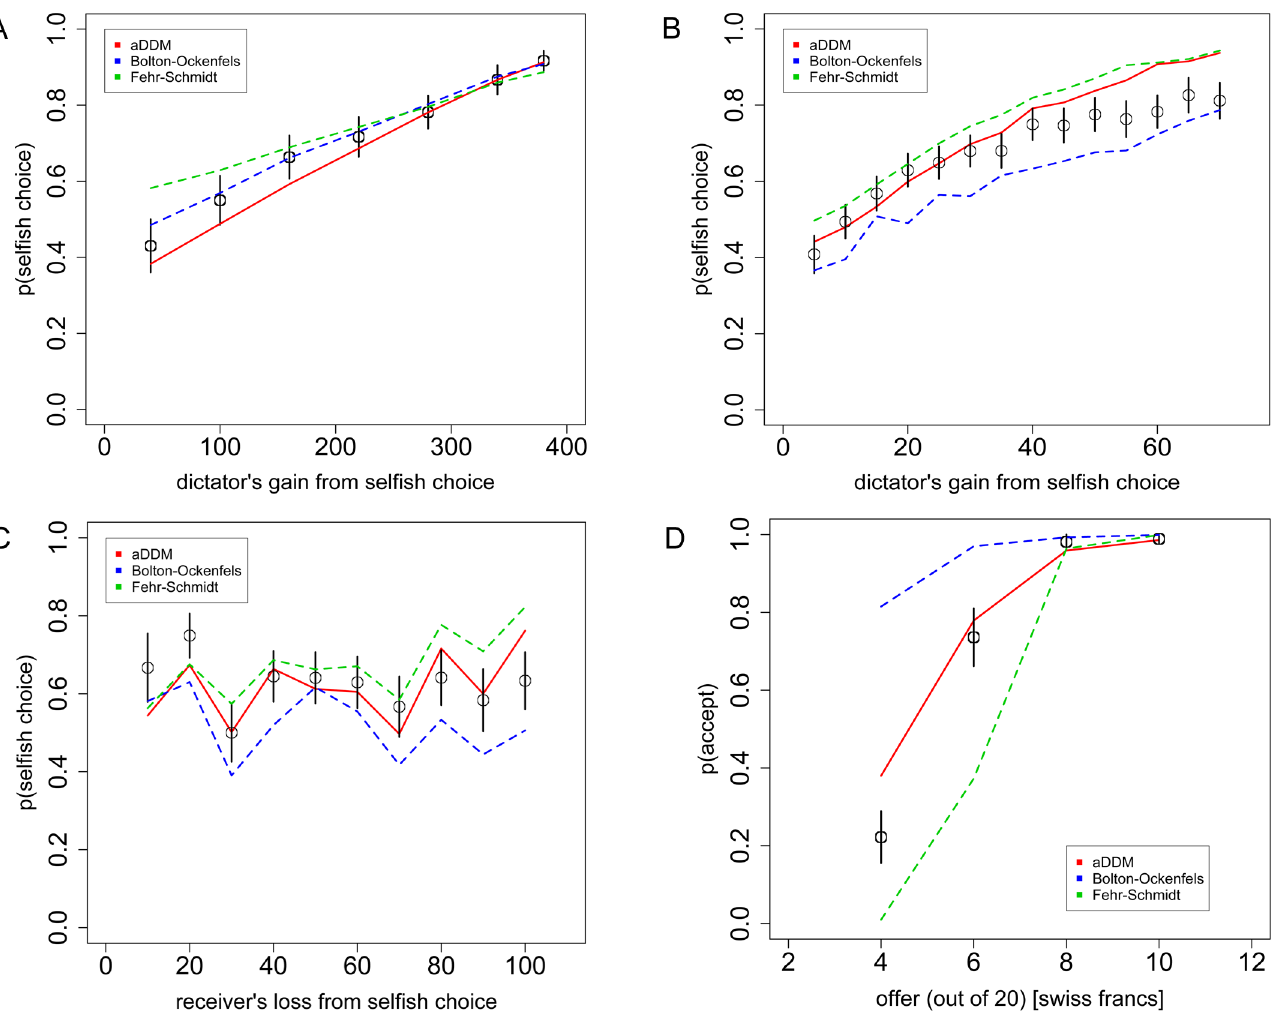
Fig 7. Alternative social preference models. A) Replication of Fig 2A, B) Fig 3A, C) Fig 4B, and D) Fig 5A, using the alternative Fehr-Schmidt and Bolton- Ockenfels models, as well as the aDDM. Black circles indicate the aggregate subject data with bars representing s.e.m. Dashed lines indicate the alternative model predictions, while the solid line indicates the aDDM